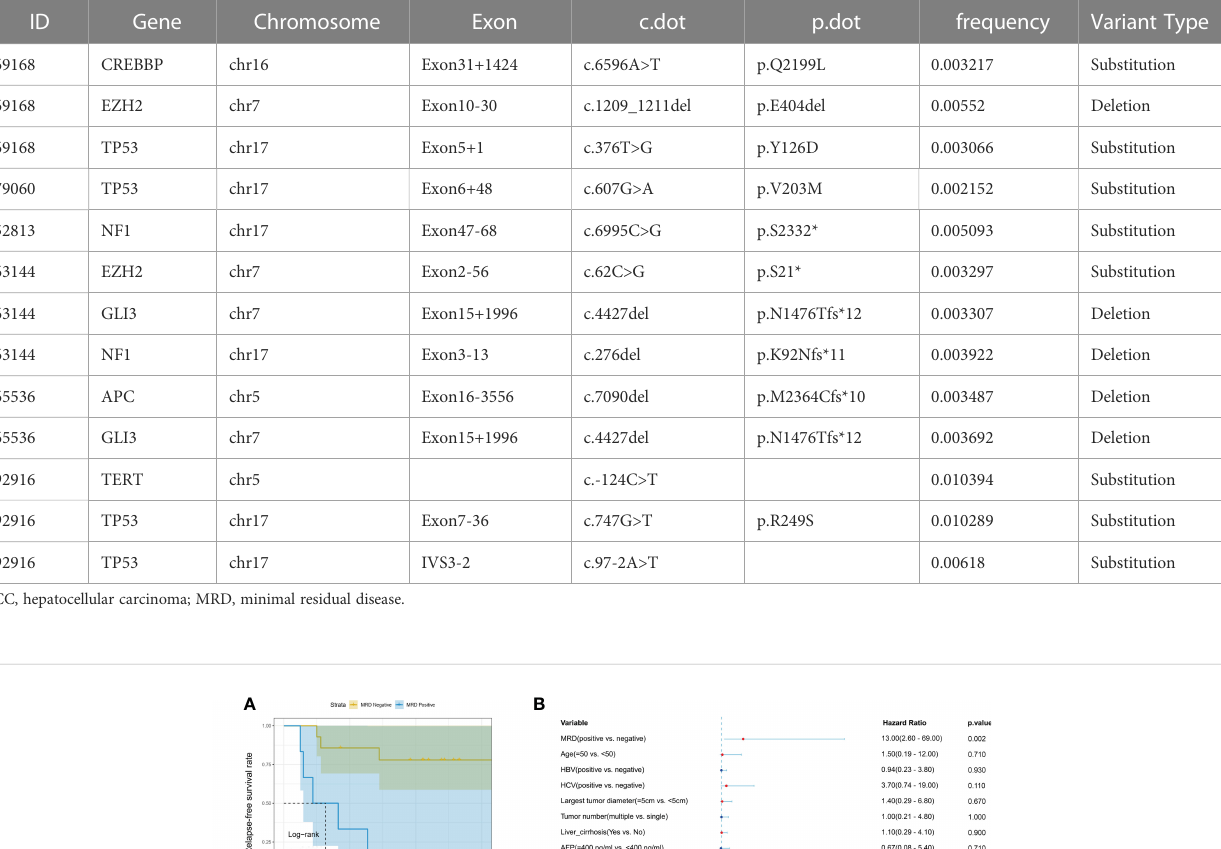
TABLE 2 The speci fi c mutational information of six MRD-positive HCC patients.